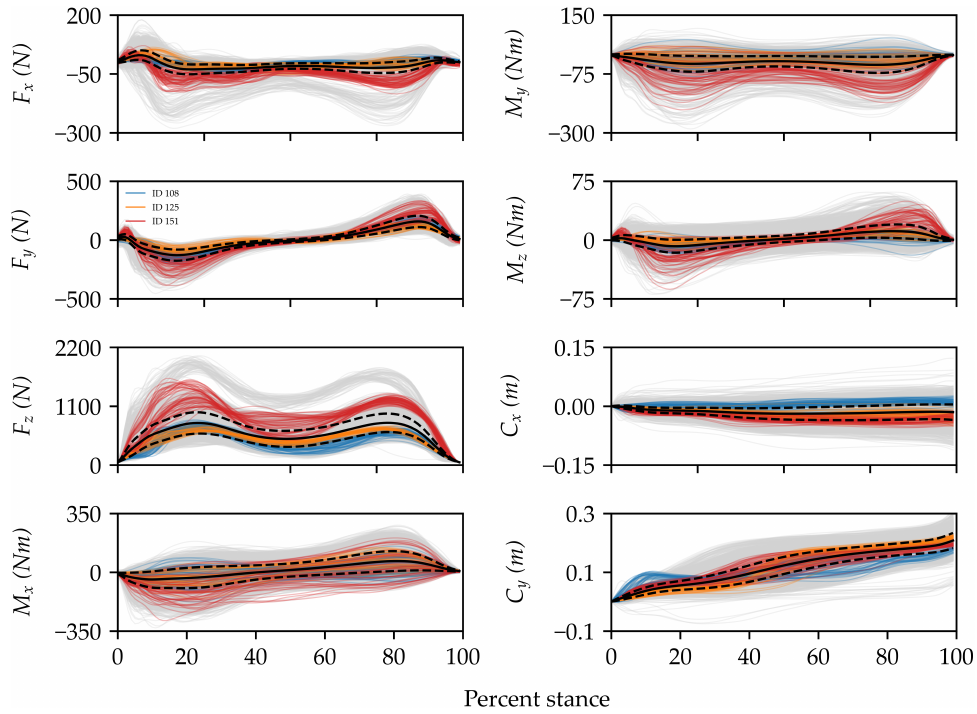
Figure 3. Visualization of all ground reaction forces ( F x —mediolateral, F y —anteroposterior, and F z —vertical), ground reaction moments ( M x , M y , and M z ), and center of pressure coordinates ( C x and C y ) for three random IDs in the dataset (colors) compared to the rest (grey). Solid and dashed black lines are the means and standard deviations across the entire dataset, respectively. For ease of interpretation, the signals have been clipped, filtered, and time normalized to 100% of the stance phase. Overall, there is a large degree of variability in the dataset, and some components are more variable than others. Table 1. Overview of key characteristics of public force platform datasets containing healthy indi- viduals. Gutenberg gait database comprises 10 datasets, each used for a separate study. All sessions were conducted on the same day in GaitRec (healthy). * Clothing conditions were not mentioned for datasets other than ForceID A and, thus, were inferred where possible. S = slower than preferred, P = preferred, F = faster than